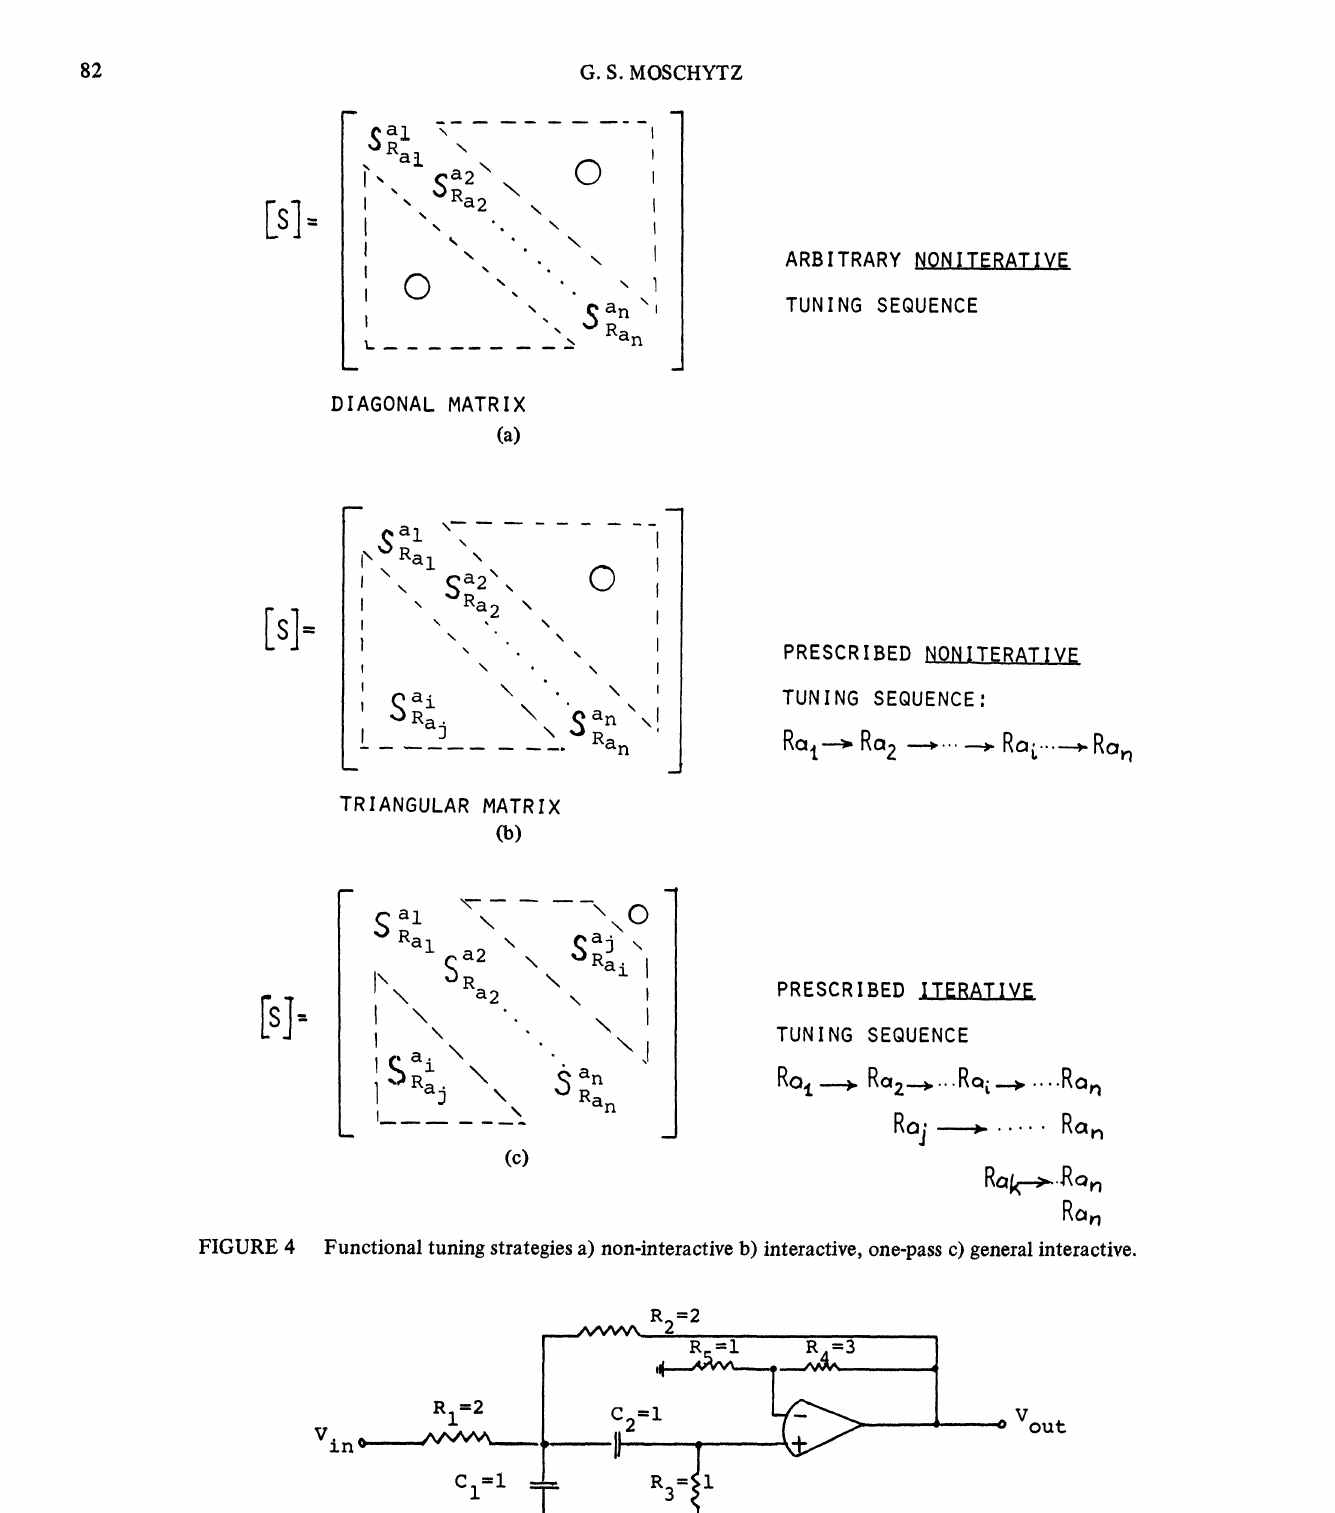
FIGURE 5 Second-order bandpass